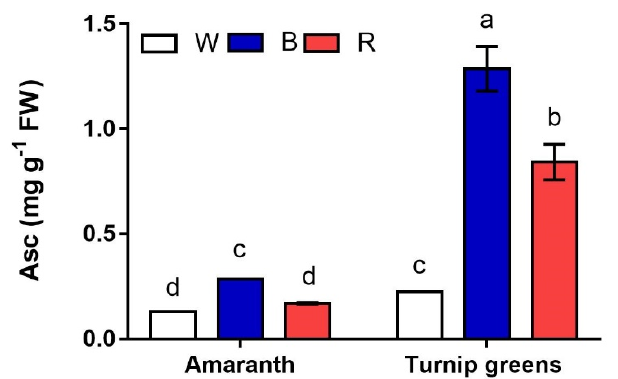
Figure 6. Interaction effect of species × light treatment (W = white, B = blue, R = red) on ascorbic acid (Asc, mg·100 g − 1 FW) of microgreens. Data are means ± standard error ( n = 3). Three biological replicates were used for the analysis. Different letters indicate significance at p ≤ 0.05 according to Tukey’s test.